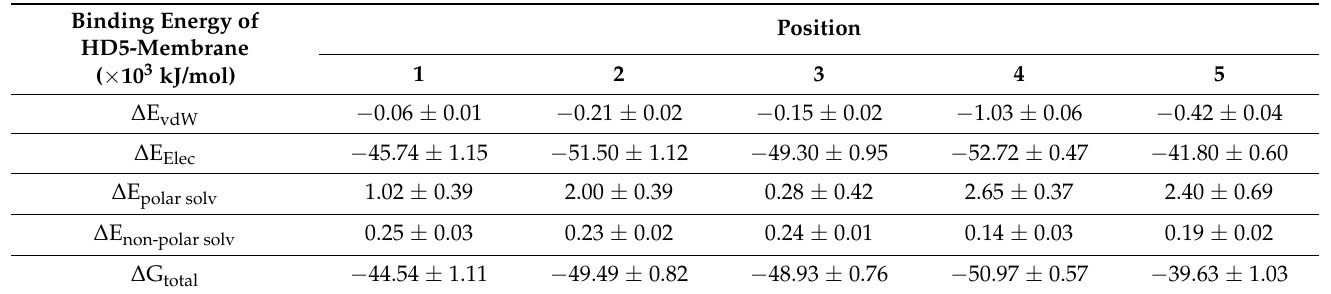
Table 2. Free energy of binding of protein and membrane at the five positions.